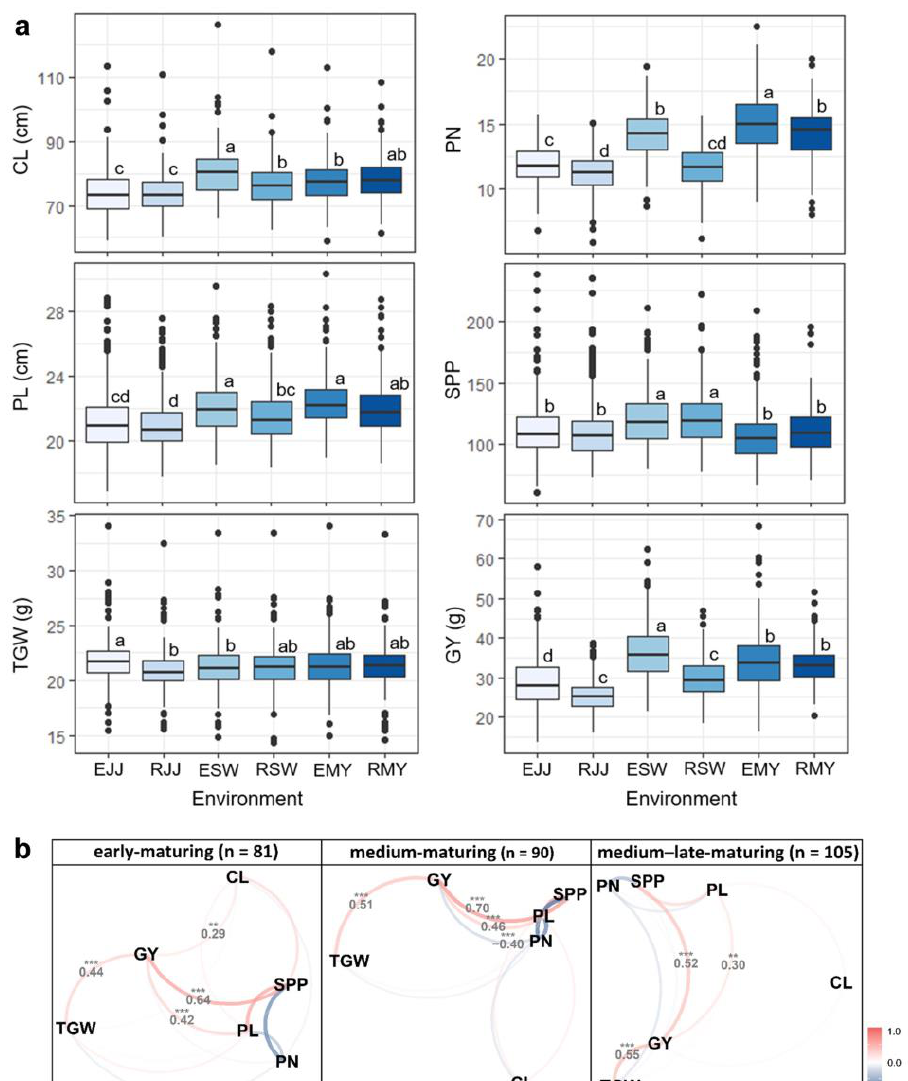
Figure 1. Performance of yield-related traits under multi-environment trials. ( a ) Variation in yield- related traits among six environments: CL — culm length; PL — panicle length; PN — panicle number